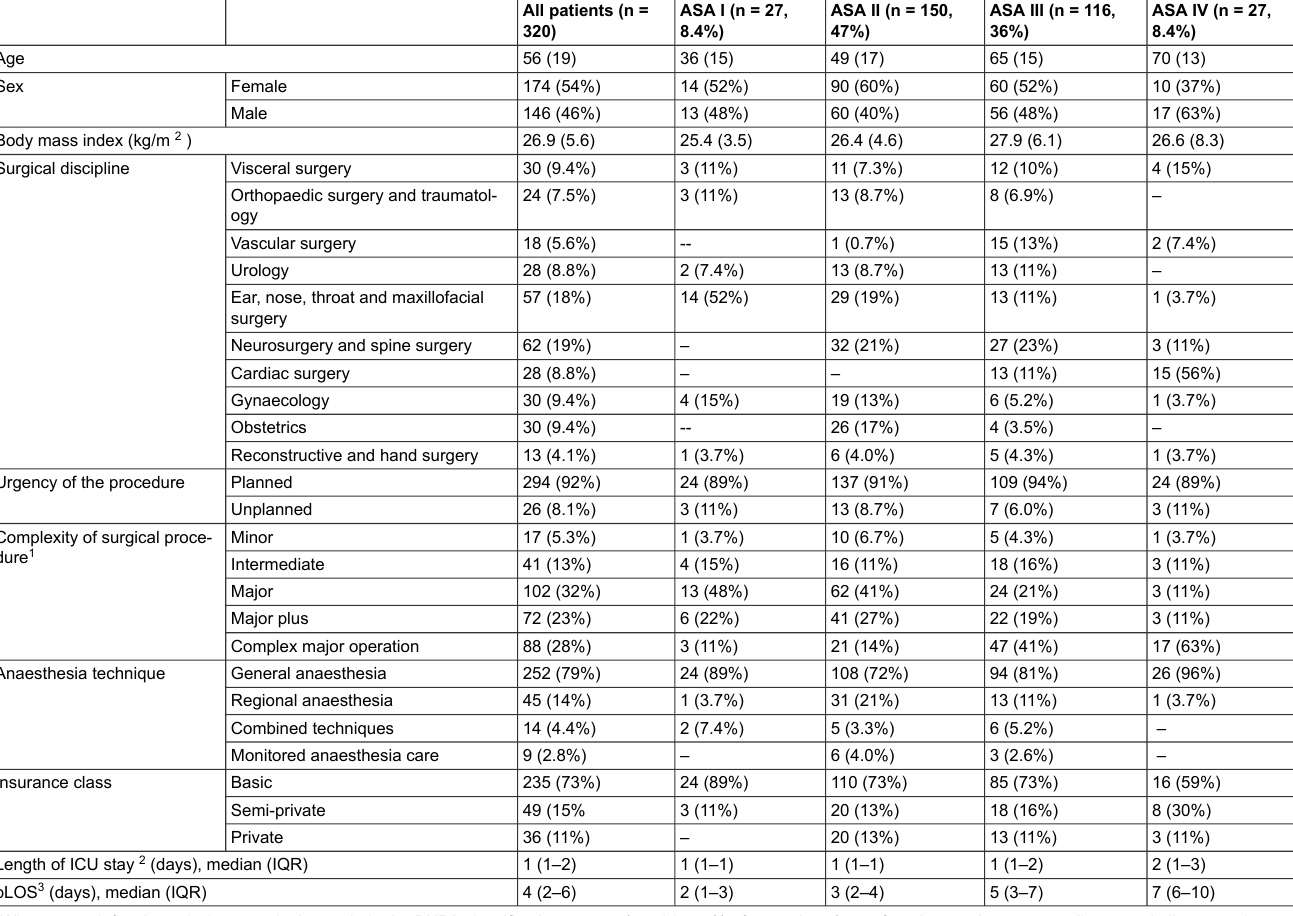
Table 1: Patient and procedural characteristics for the total study population (n = 320) and for the different ASA PS classes Quantitative variables are reported as mean (SD), quantitative as number